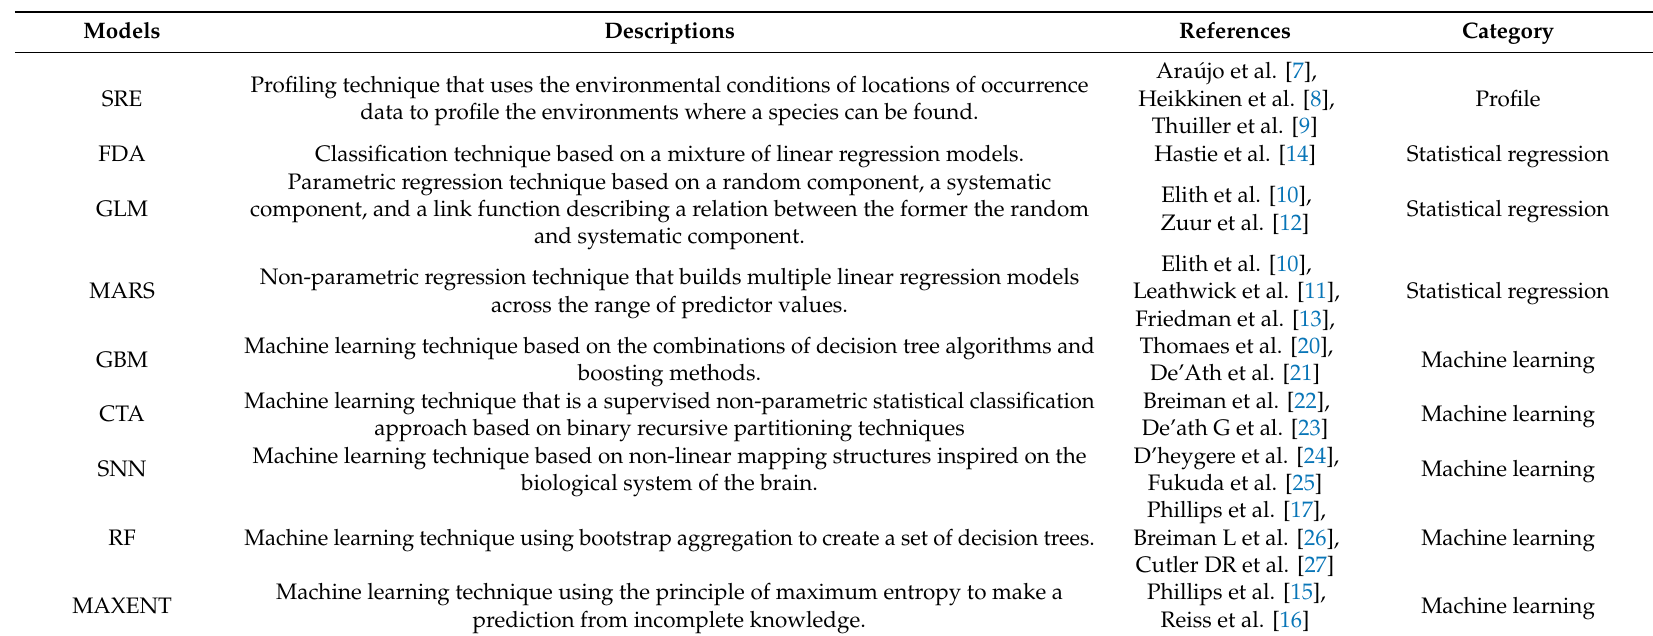
Table 1. Overview of habitat suitability modeling